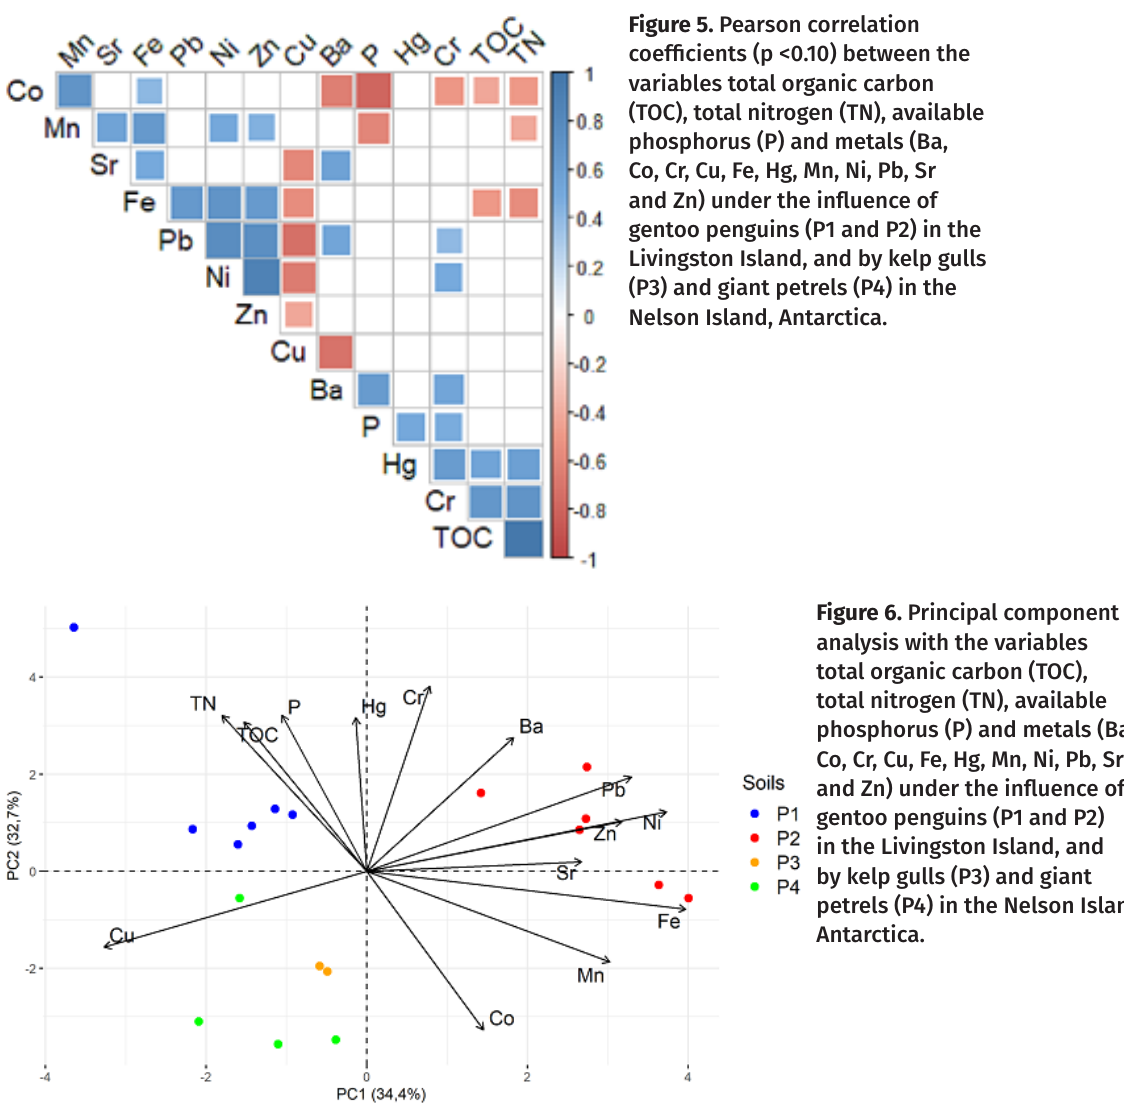
Figure 6. Principal component analysis with the variables total organic carbon (TOC), total nitrogen (TN), available phosphorus (P) and metals (Ba, Co, Cr, Cu, Fe, Hg, Mn, Ni, Pb, Sr and Zn) under the influence of gentoo penguins (P1 and P2) in the Livingston Island, and by kelp gulls (P3) and giant petrels (P4) in the Nelson Island, Antarctica.